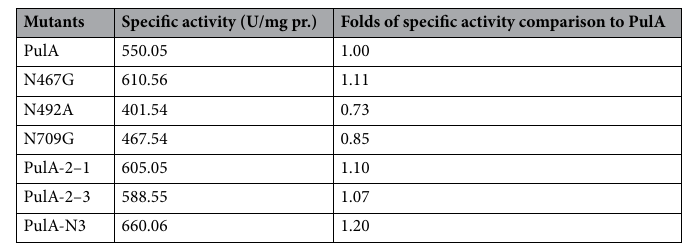
Table 2. Specific activities (average of triplicate experiments) of PulA and mutants.